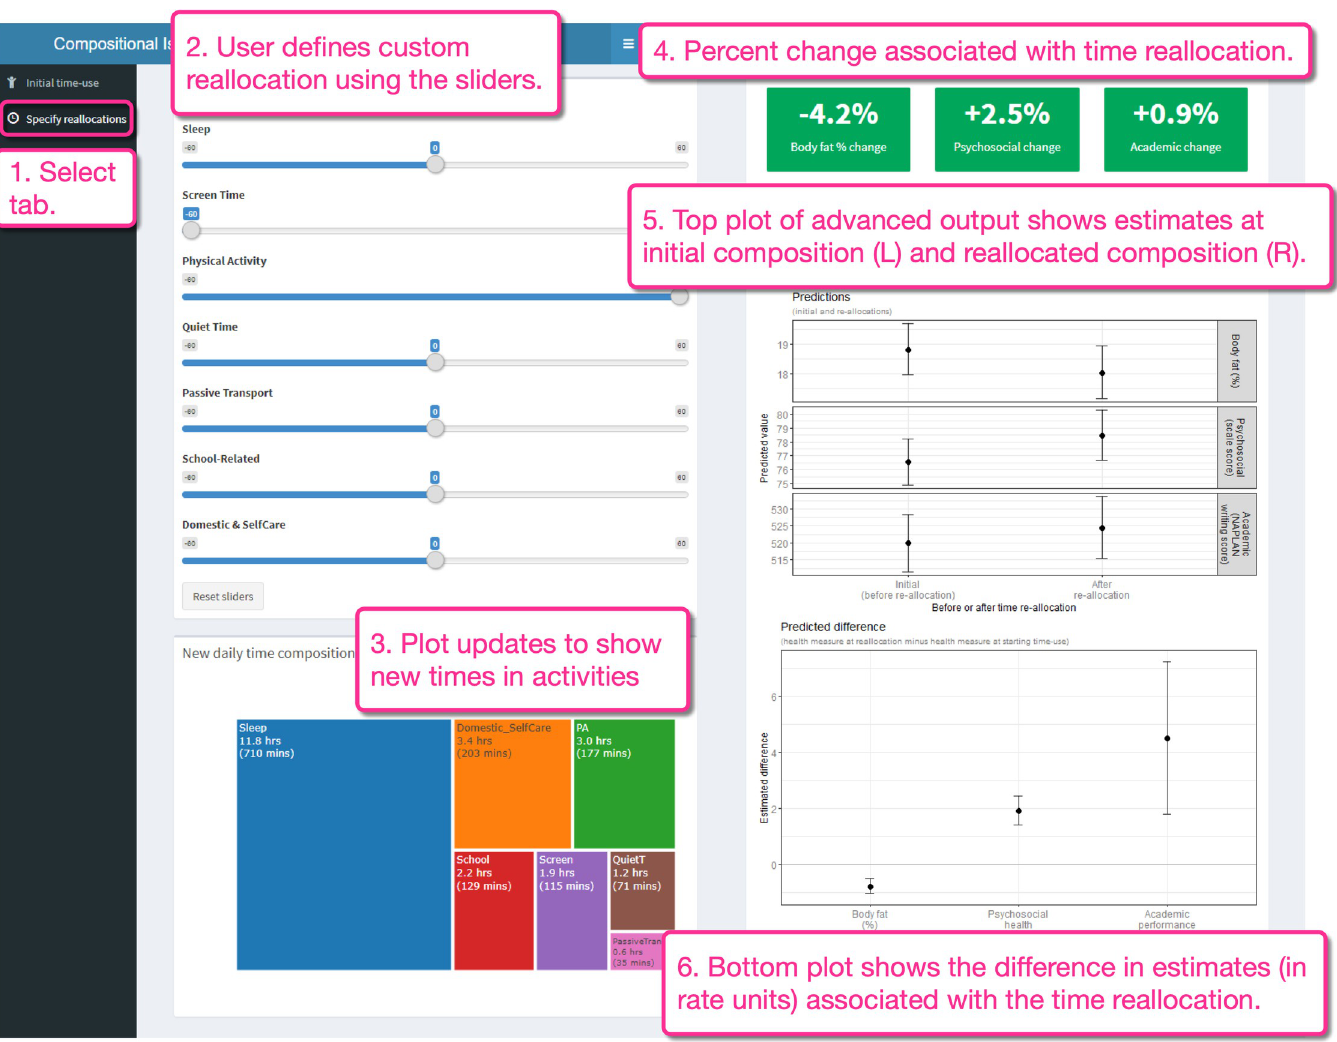
Fig 3. Specification of custom simple one-for-one time-use reallocation using the app, and visualization of advanced output. Initial time-use composition was the compositional mean of the sample: Sleep = 11 h 50 min; Screen time = 2 h 55 min; Physical activity = 1 h 57 min; Quiet time = 1 h 11 min; Passive transport = 35 min; School-related activities = 2 h 09 min; Domestic/self-care activities = 3 h 23